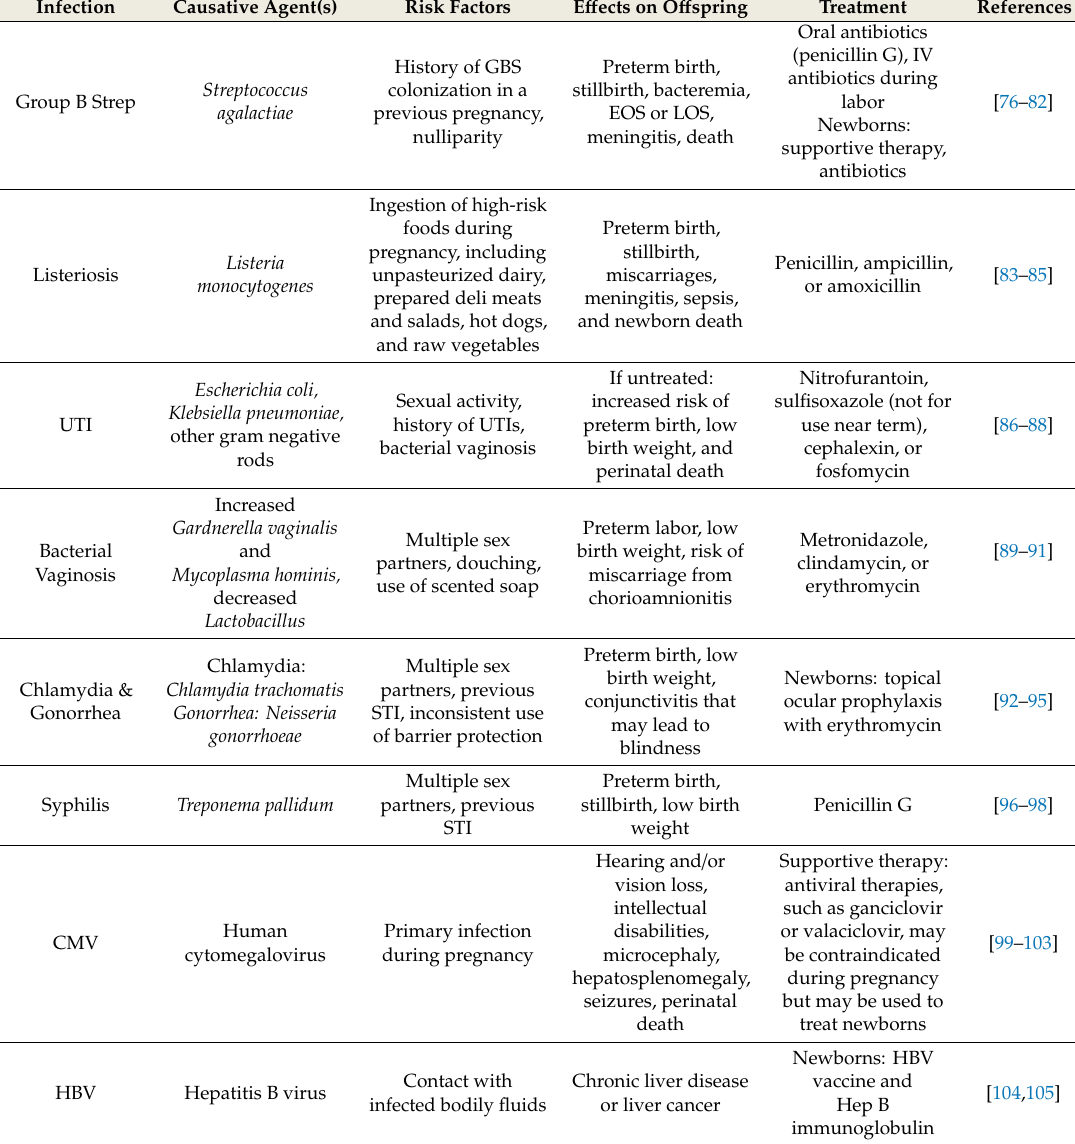
Table 1. List of common infections in pregnancy and associated e ff